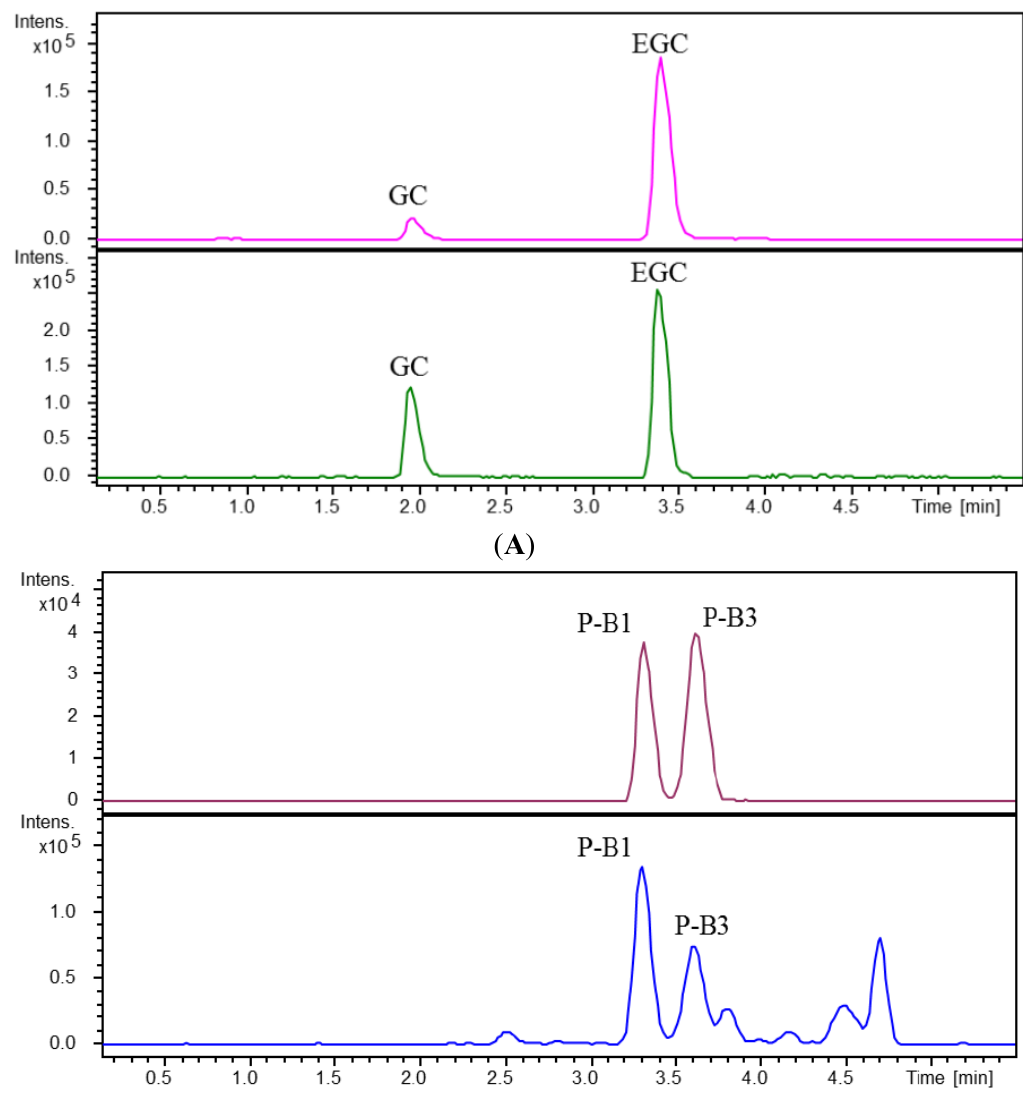
Figure 3. Extracted ion chromatograms (EIC) of GC and EGC ( A ); P-B C and EC ( C ) in mixed standards (upper panel) and in an extract of the Ginkgo leaves (lower